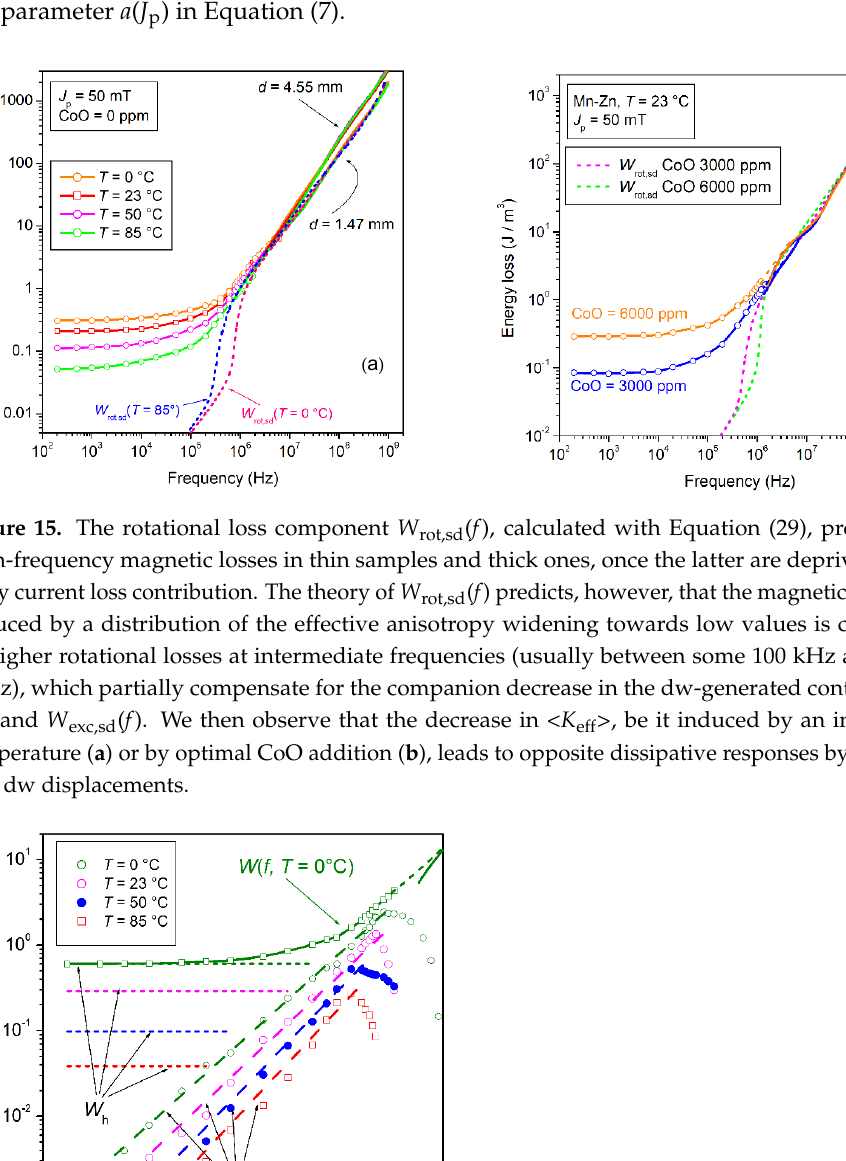
Figure 14. Decomposition of permeability and energy loss in a 4000 ppm CoO Mn-Zn ferrite. ( a ) The rotational permeability components μ ′ rot ( f ) and μ ″ rot ( f ) are extracted from the measured μ ′ ( f ) and μ ″ ( f ), according to the method discussed in Section 2.2. They are fully described in terms of μ ′ rot,sd ( f ) and μ ″ rot,sd ( f ), according to Equation (29). ( b ) The energy loss component W rot,sd ( f ), correspondingly calculated using Equation (13), equally fits the high-frequency losses in the thin ( d = 1.30 mm) eddy- current free samples. The excess loss is finally obtained by subtraction: W exc,sd ( f ) = W ( f ) − W h − W rot,sd ( f ). The power-law dependence on frequency W exc,sd ( f ) ∝ f 0.91 is predicted by Equation (32), with the parameter m = 0.1.